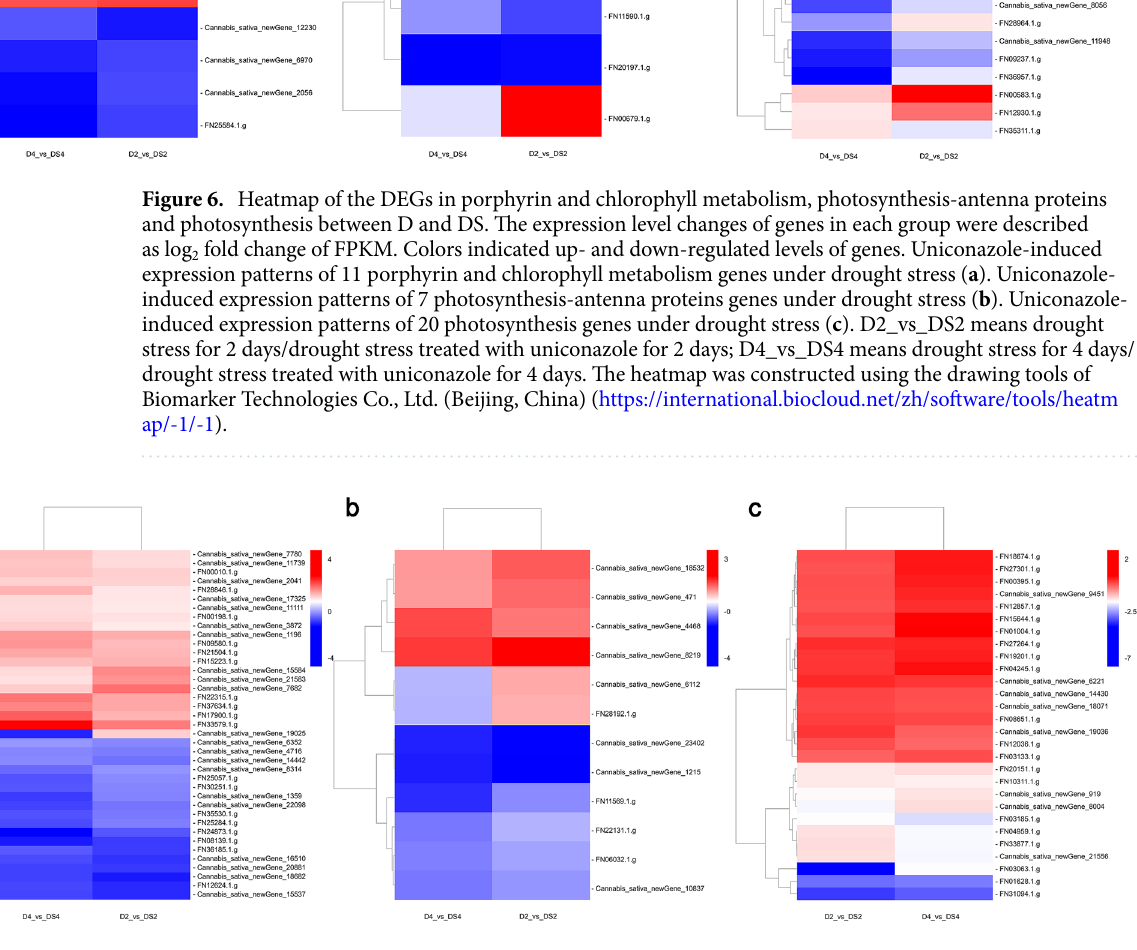
Figure 7. Heatmap of the DEGs in starch and sucrose metabolism, nitrogen metabolism and plant hormone signal transduction metabolism between D and DS. The expression level changes of genes in each group were described as log 2 fold change of FPKM. Colors indicated up- and down-regulated levels of genes. Uniconazole- induced expression patterns of 39 starch and sucrose metabolism genes under drought stress ( a ). Uniconazole- induced expression patterns of 12 nitrogen metabolism genes under drought stress ( b ). Uniconazole-induced expression patterns of 28 plant hormone signal transduction metabolism genes under drought stress ( c ). D2_ vs_DS2 means drought stress for 2 days/drought stress treated with uniconazole for 2 days; D4_vs_DS4 means drought stress for 4 days/drought stress treated with uniconazole for 4 days. The heatmap was drawn using the BMKCloud tools (Biomarker Technologies Co., Ltd., Beijing, China) (https:// inter natio nal. biocl oud. net/ zh/ softw are/ tools/ heatm ap/-